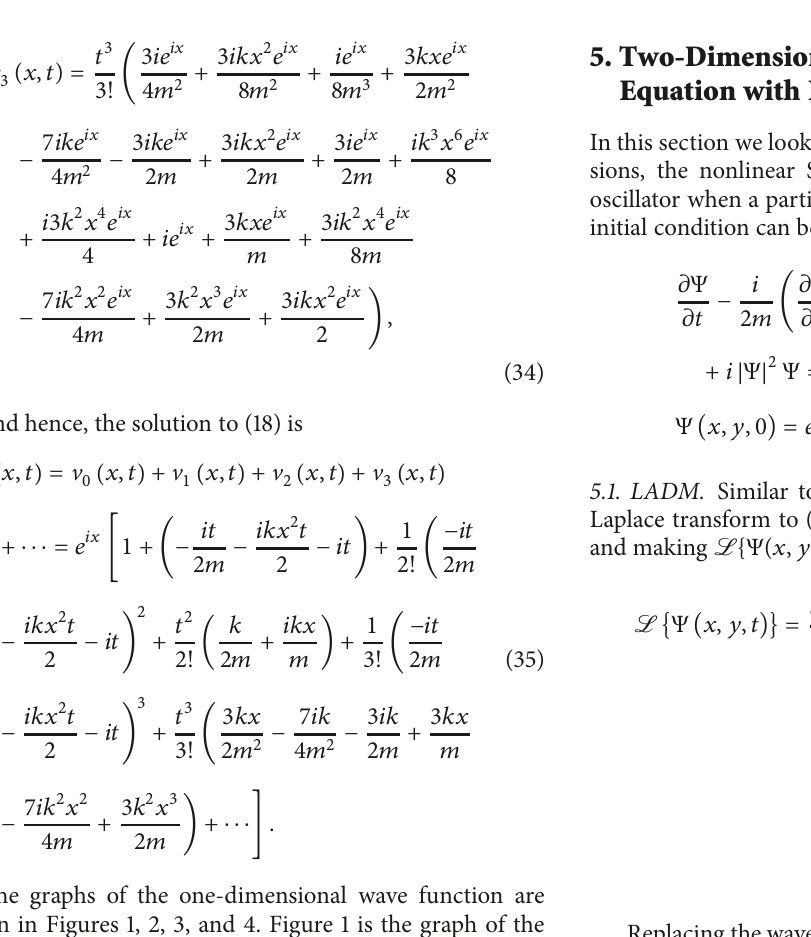
Figure 1: Real solution of the one-dimensional wave function obtained by LADM and